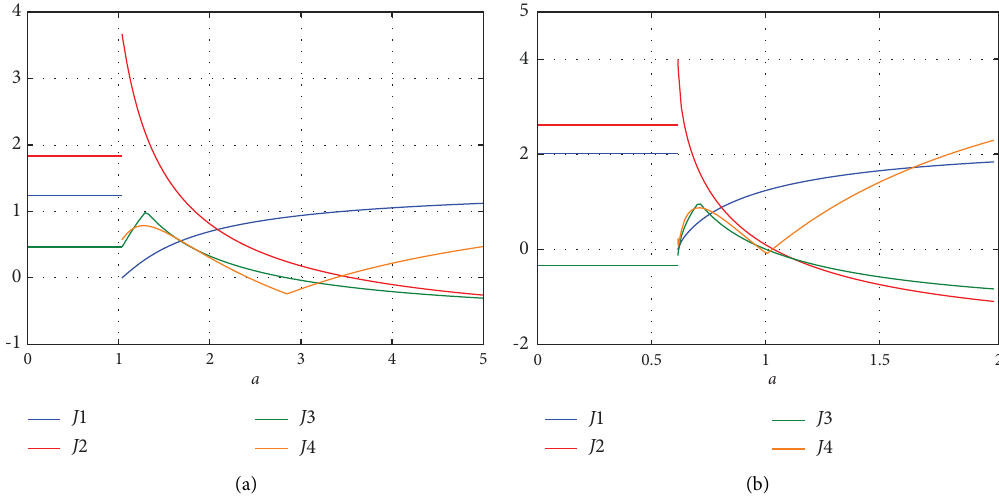
� 0 . 61357. (Te horizontal lines to C